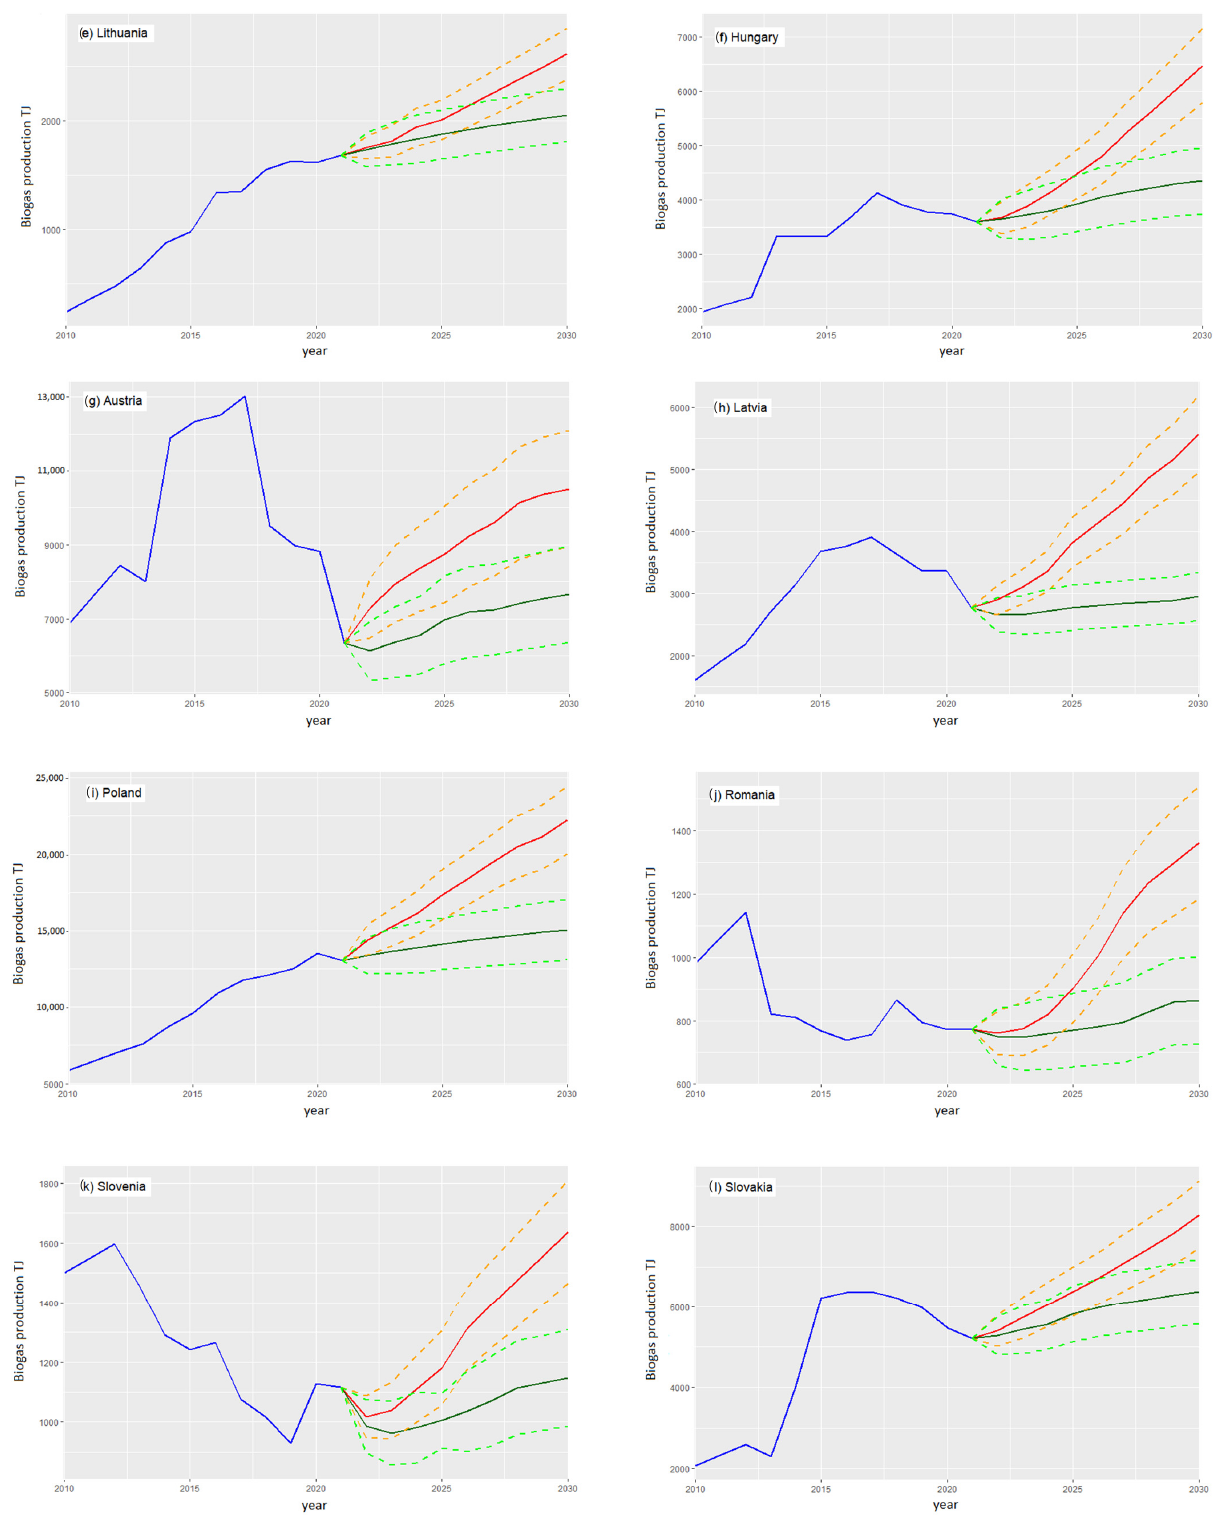
Figure 5. Biogas production forecast based on three regressors (green curves) and on four regressors (red curves) with the confidence interval Lo–Hi 95% (dashed curves). Biogas production to date (dark blue curves).